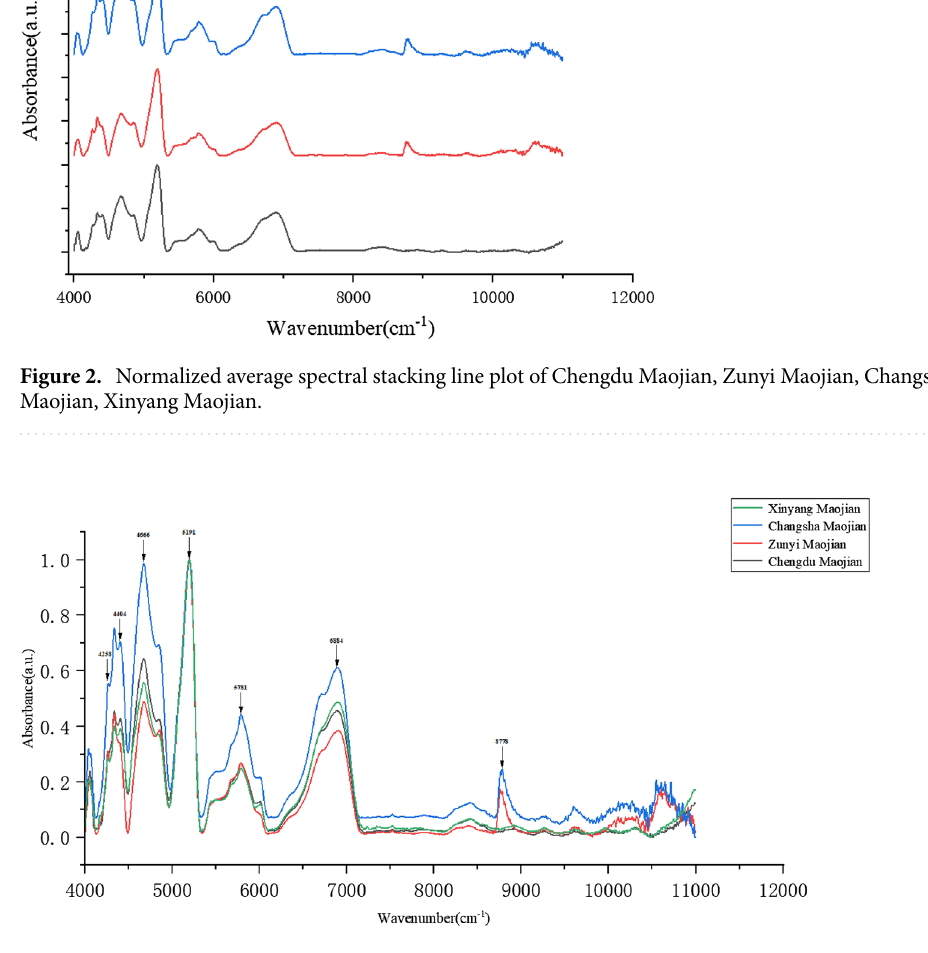
Figure 3. Comparison of normalized average spectral peaks of Chengdu Maojian, Zunyi Maojian, Changsha Maojian, and Xinyang